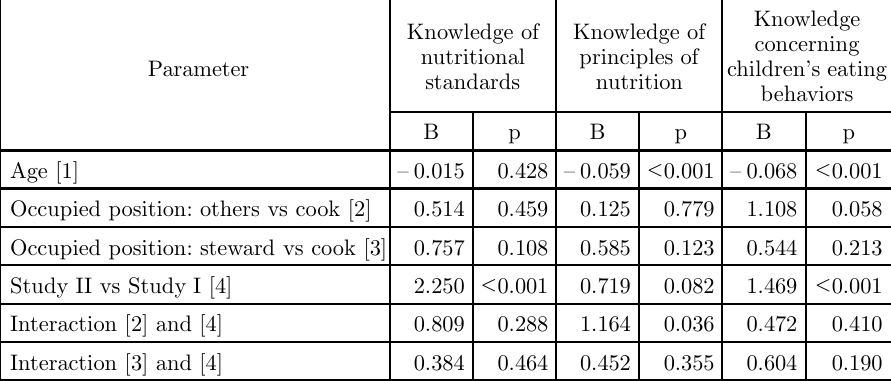
Table 2. Generalized Linear Models explaining knowledge in 3 studied areas including professional position as covariate